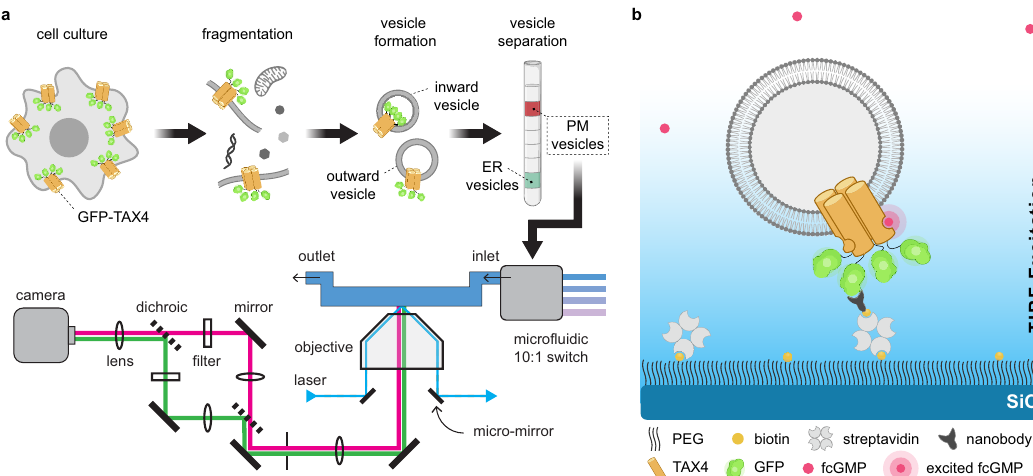
Fig. 1 Immobilization of cell-derived nanovesicles for single-molecule imaging of membrane proteins. a Schematic illustrating both sample preparation and the imaging setup. Brie fl y, cells expressing the membrane protein of interest (e.g., GFP-TAX-4) are fragmented using N 2 cavitation to spontaneously form nanoscale vesicles, some of which contain the protein of interest in a mixture of inward and outward-facing orientations. Vesicles comprised of membrane from either the plasma membrane (PM) or endoplasmic reticulum (ER) are further separated by gradient ultracentrifugation. The fraction of PM vesicles is applied to a sample chamber for immobilization and imaging with micromirror total internal re fl ection (mmTIRF) microscopy. b Illustration of an individual immobilized vesicle in the sample chamber. The chamber consists of a glass coverslip coated with a layer of PEG doped with PEG-biotin to which a biotinylated anti-GFP nanobody (bait protein) is attached via streptavidin. Vesicles containing GFP-TAX-4 oriented such that GFP is exposed to the extravesicular solution is immobilized at nanobody locations on the optical surface. TIRF excitation, indicated by the blue gradient, ensures that bulk freely diffusing fl uorescent ligand (e.g., fcGMP) above the vesicle layer are not appreciably excited. Fluorescence from the vesicle layer is imaged on an EMCCD as depicted to the left. Note that the vesicle is not drawn to scale as it would on average have a diameter about 20-fold larger than